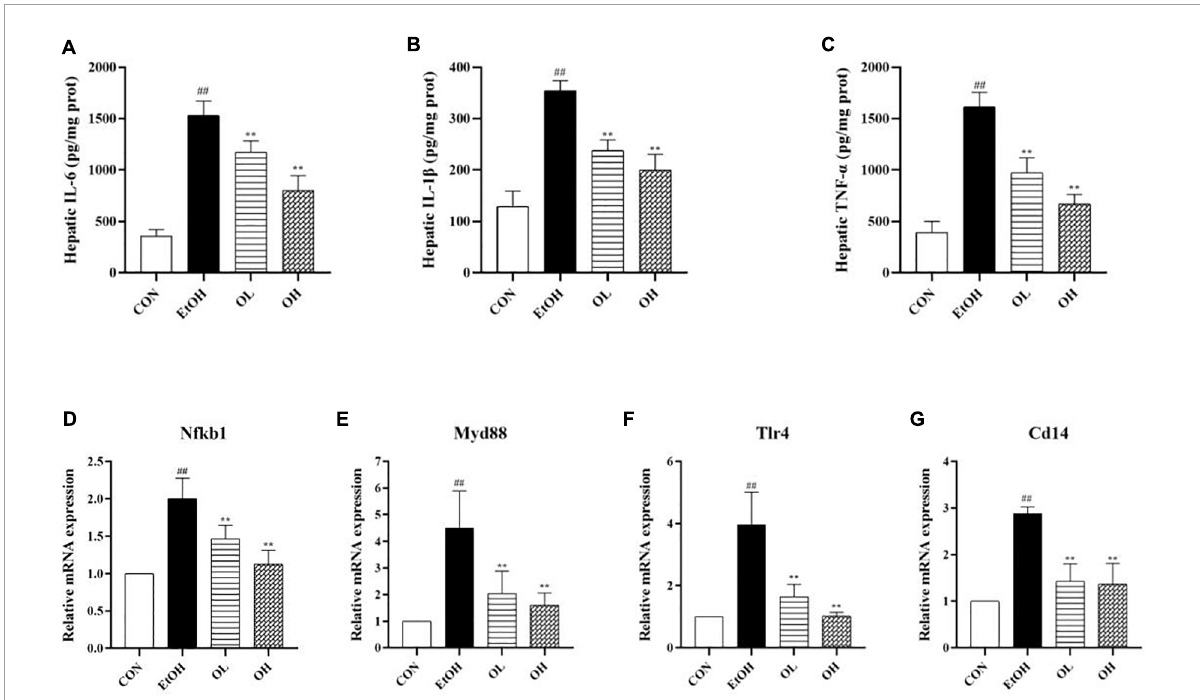
FIGURE5 Effect of OEB treatment on hepatic inflammatory indicators and the expression levels of TLR4/NF- κ B signaling pathway-related genes of ALD mice: (A) serum NO; (B) hepatic IL-6 content; (C) hepatic IL-1 β content; (D) hepatic TNF- α content; (E) Nfkb1; (F) Myd88; (G) Tlr4; and (D) Cd14. CON, control group; EtOH, ethanol administration group; OL, low-dose OEB group; and OH, high-dose OEB group. Data are presented as “mean ± SD”. N = 8, for all groups. ## EtOH versus CON, P < 0.01; ** OL or OH versus EtOH, P < 0.01.